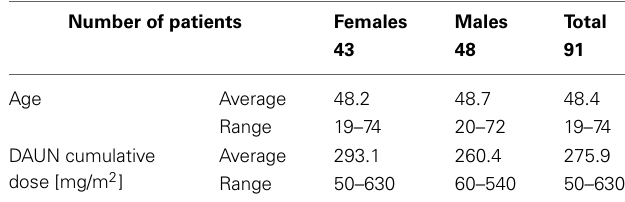
Table 1 | Characteristics of the AML study